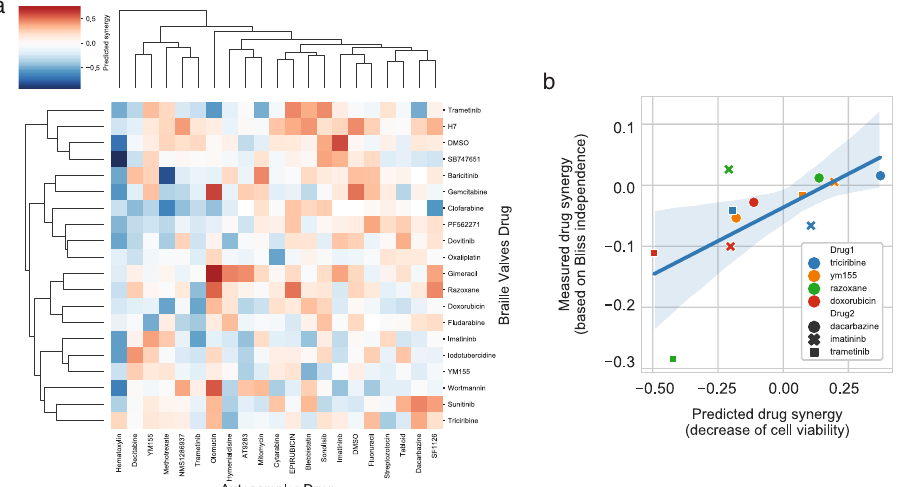
Fig. 6 | Synergy predictions and validation of the high-throughput Combi-Seq screen. a Heatmap showing predicted synergy scores that were determined by comparingviabilitiesfromall420drugcombinationstocorrespondingsingledrug treatments. b Correlation between experimental and predicted cell viability (Pearson correlation r =0.66, p =0.018, R 2 =0.44). Drug synergy (y-axis) was